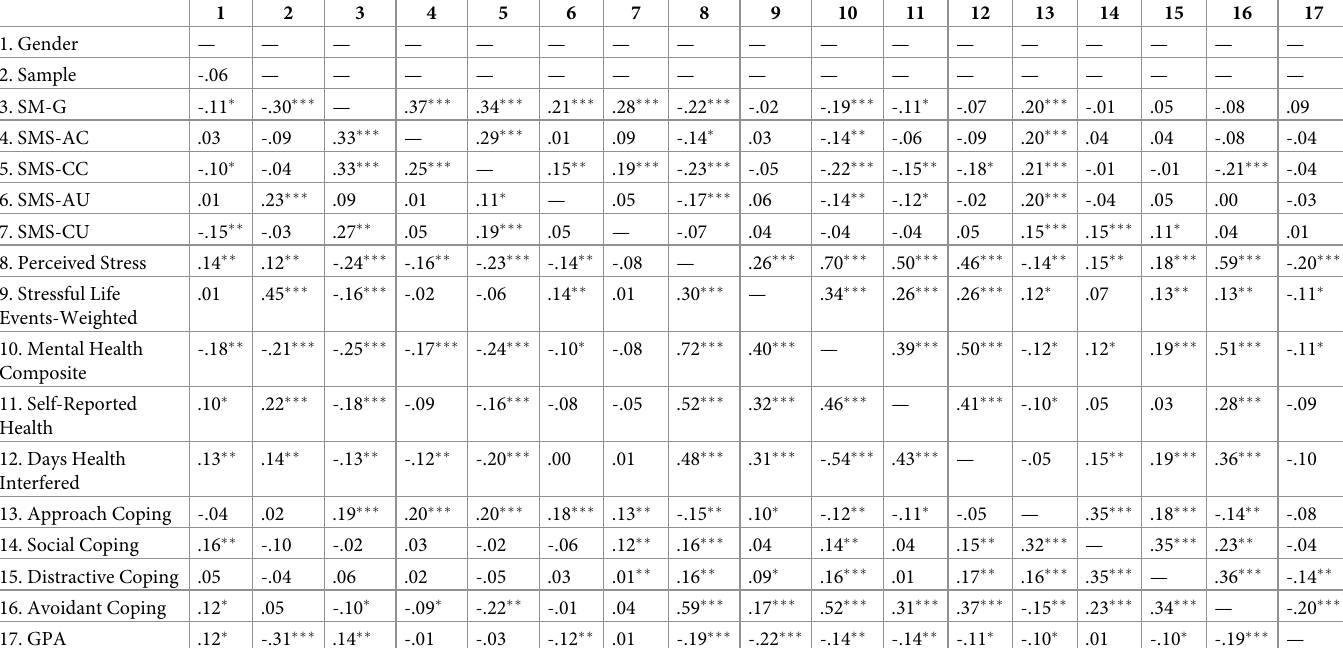
Table 2. Zero-order and partial (controlling for gender and sample) correlations among study